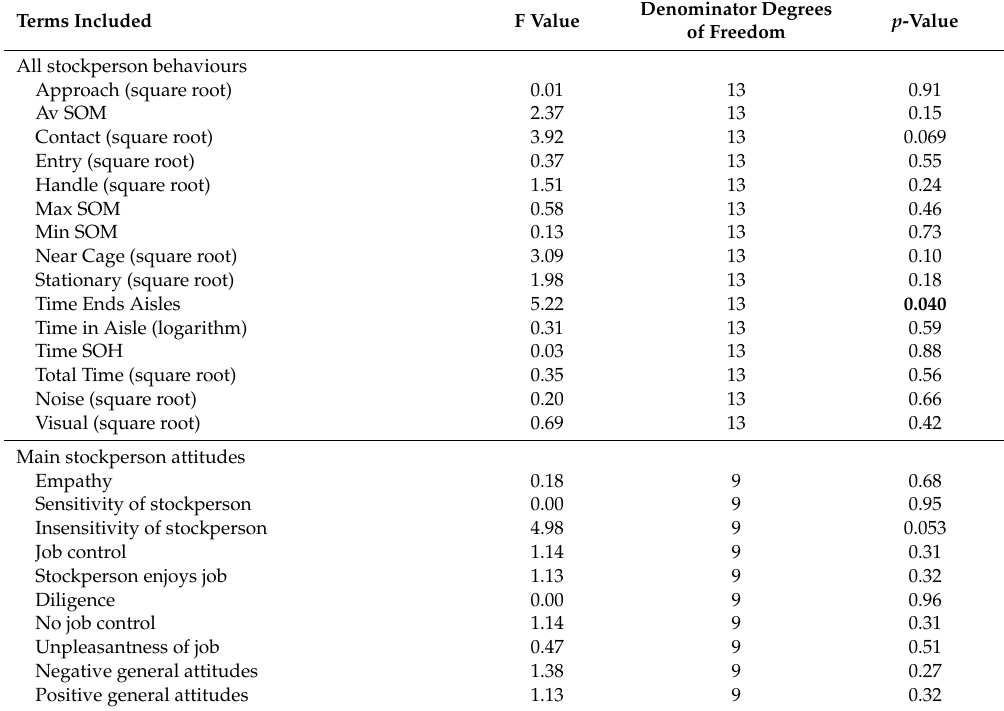
Figure 3. Relationship between albumen corticosterone concentration and the average withdrawal distance in the Stroll Test. Error bars represent 95% confidence intervals.